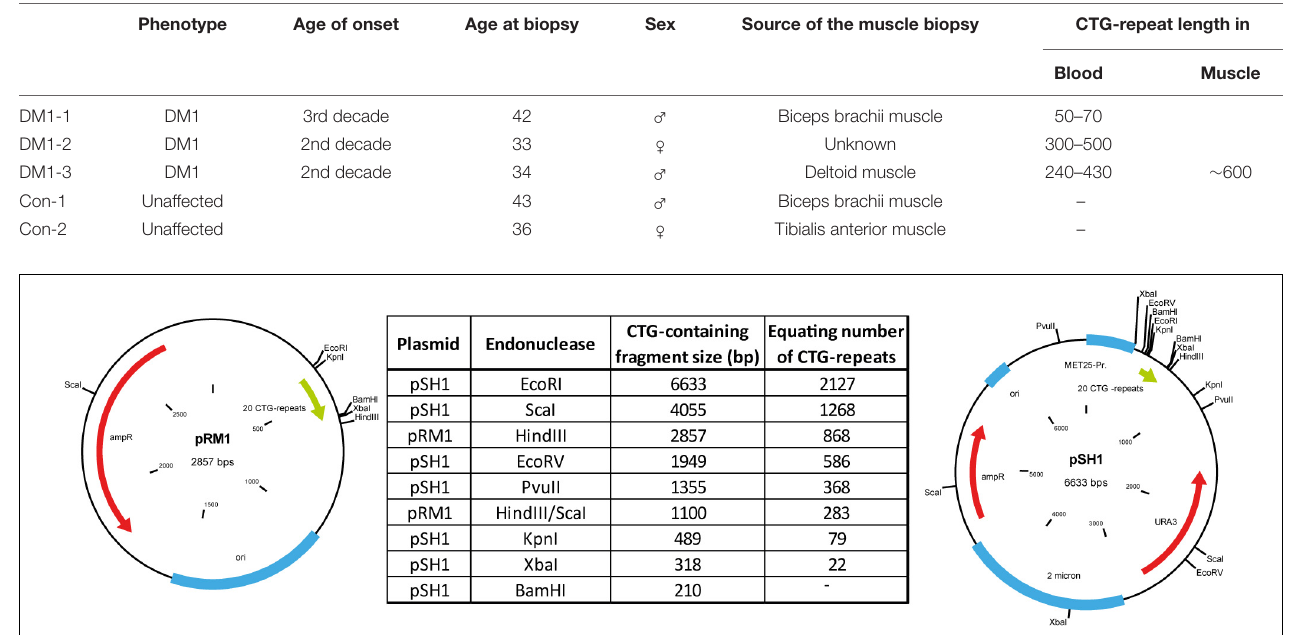
TABLE 1 | Primary myoblast cultures used in this study.